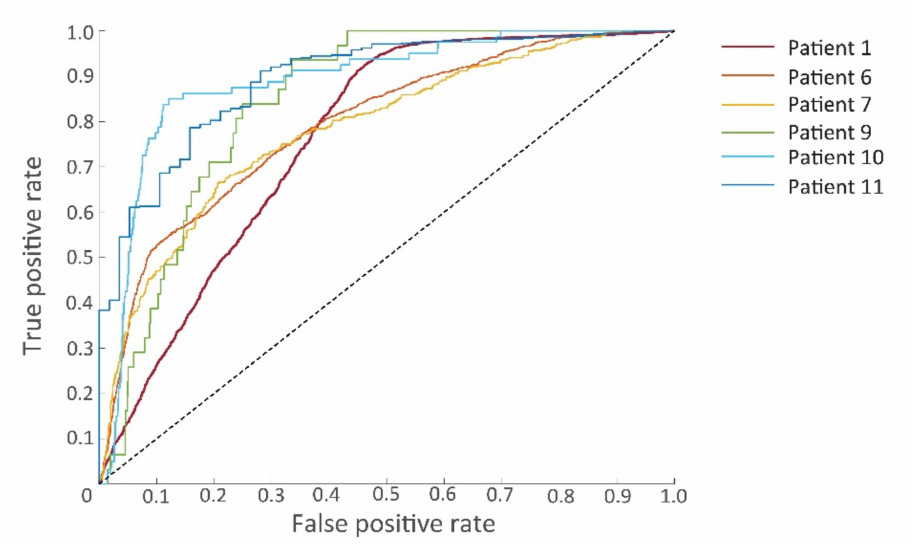
Figure 7. Receiver operating characteristic (ROC) curves of the six patients for whom samples contained both tumorous and non-tumorous